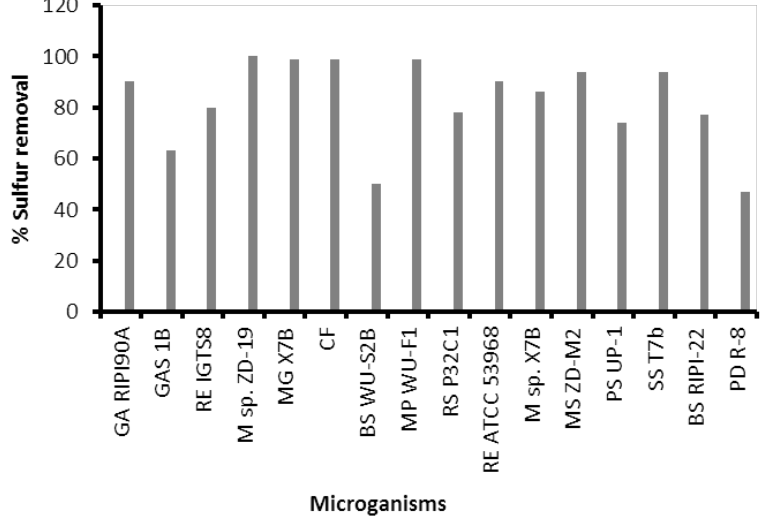
Figure 2. The percentage (%) desulfurizing ability of various microorganisms. Table 2. Optimized conditions of biodesulfurization process (Adapted from [6]). Bacteria Optimum